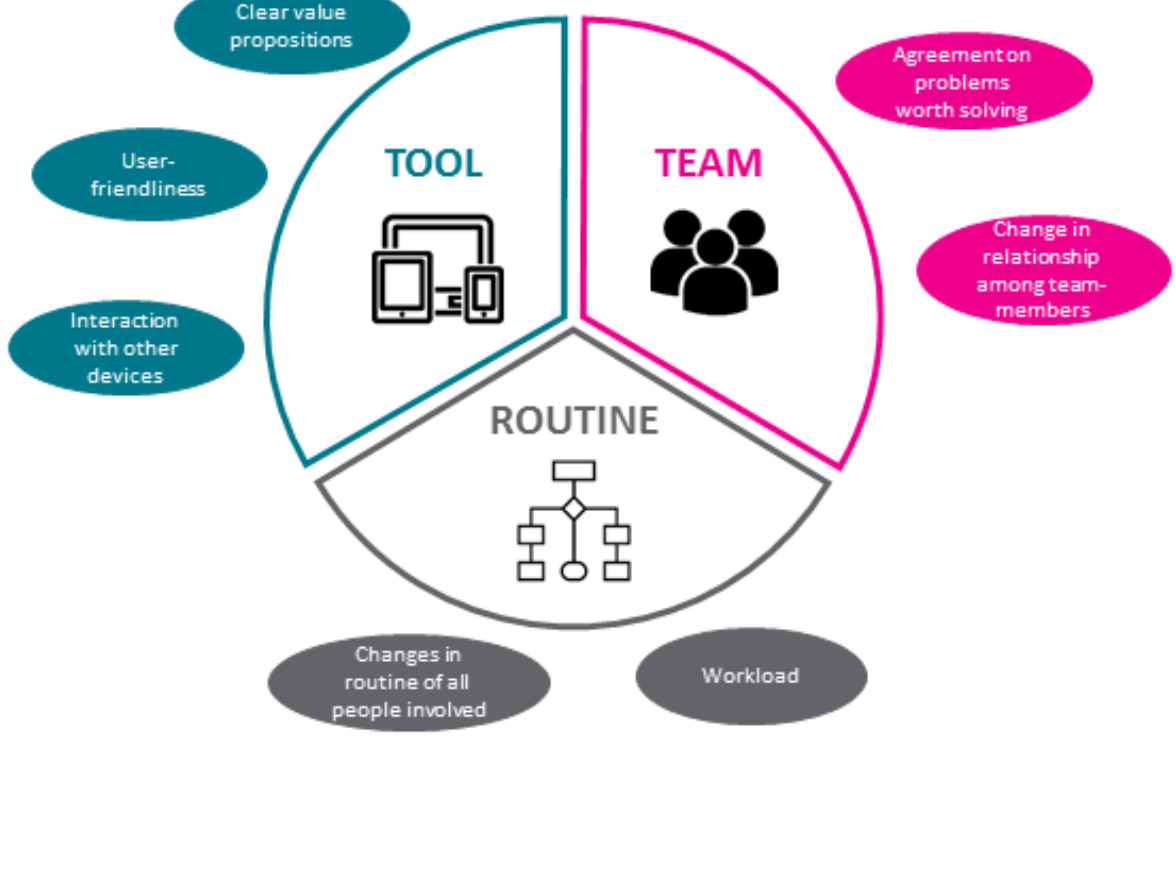
Figure 1. Visual representation of the main factors in the Tool+Team+Routine